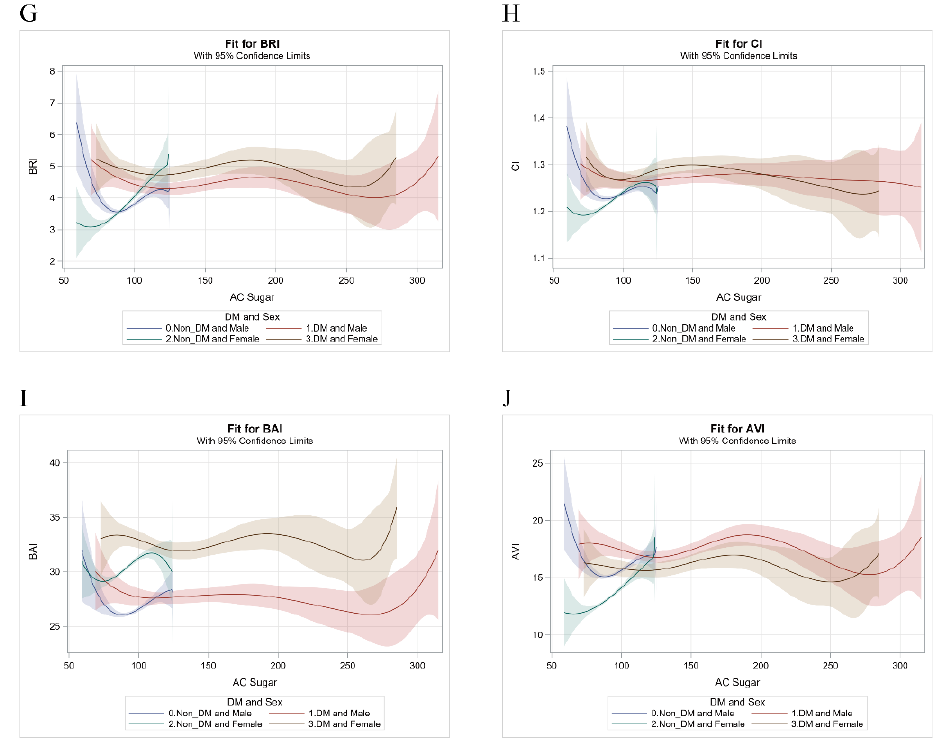
Figure 1. The relationship between fasting glucose (AC sugar) and various obesity-related indices by DM and sex: BMI ( A ), WC ( B ), HC ( C ), WHR ( D ), WHtR ( E ), LAP ( F ), BRI ( G ), CI ( H ), BAI ( I ) and AVI ( J ). Abbreviations. DM, diabetes mellitus; BMI, body mass index; WC, waist circumference; HC, hip circumference; WHR, waist-to-hip ratio; WHtR, waist-to-height ratio; LAP, lipid accumulation product; BRI, body roundness index; CI, conicity index; BAI, body adiposity index; AVI, abdominal volume